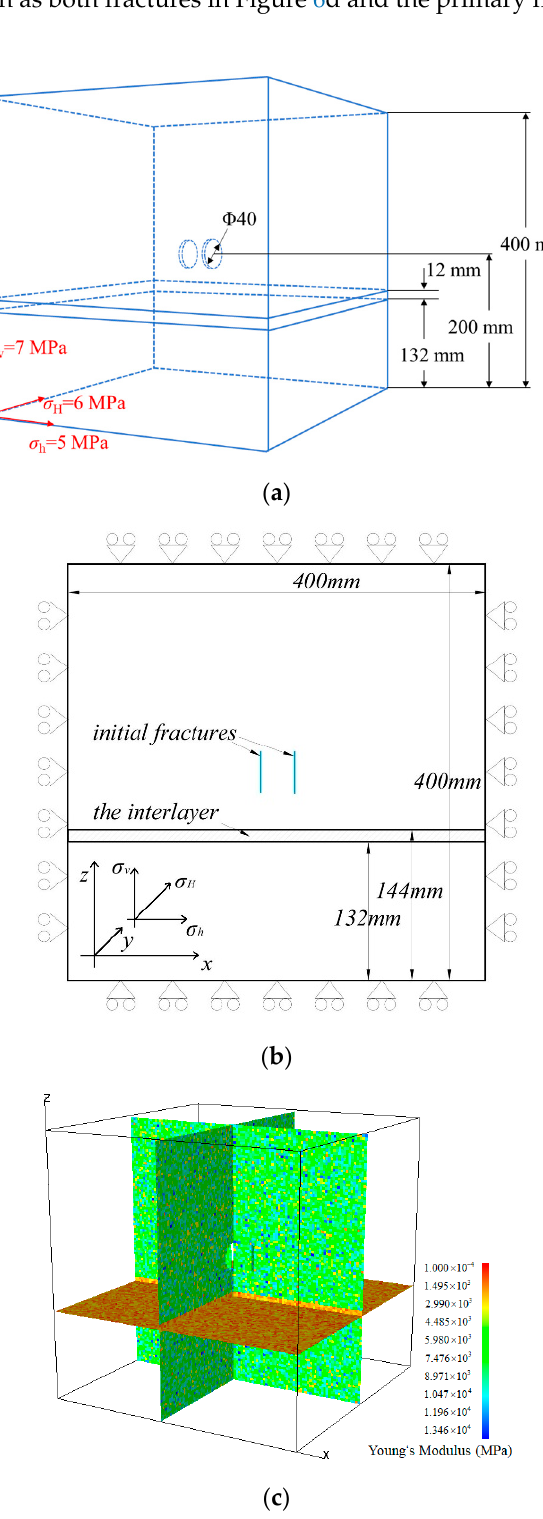
Figure 4. Configurations of multilayered laboratory-scale models: ( a ) Configuration of the 3D model; ( b ) cross-section of the 3D model; ( c ) slices at x = 0.181 m, y = 0.2 m, and z = 0.132 m of simulated model Multi-E1.